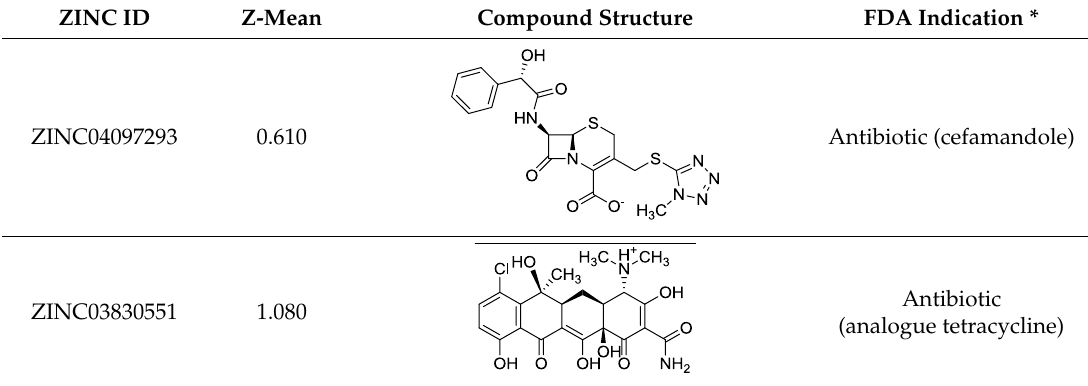
Figure 2. Clustering pattern based on ligand contact amino acid showing the four major groups. In cyan, group 1, in blue, group 2, in red, group 3, and in green, group 4. Arrows indicate the compound ZINC03830554 and ZINC03831344 mentioned in the text.